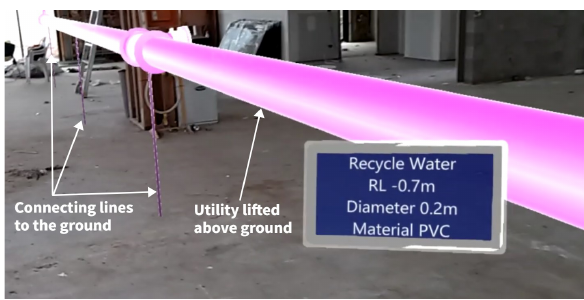
Figure 12 . Selected utility in "General + Elevator